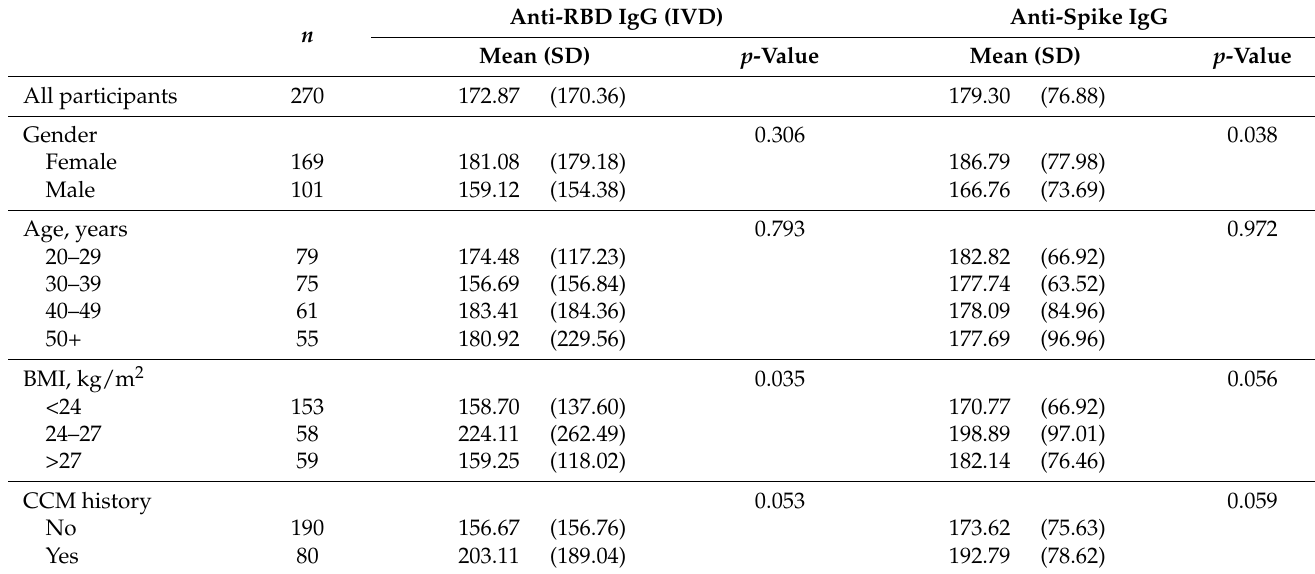
Table 2. Subgroup analyses of anti-RBD and anti-spike IgG levels after the prime–boost